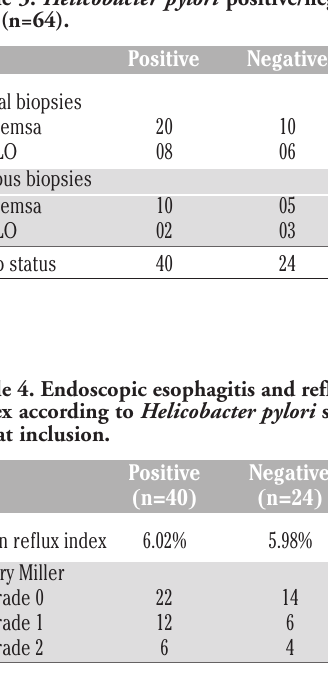
Table 1. Age of patients, reflux index and symptoms at inclusion.